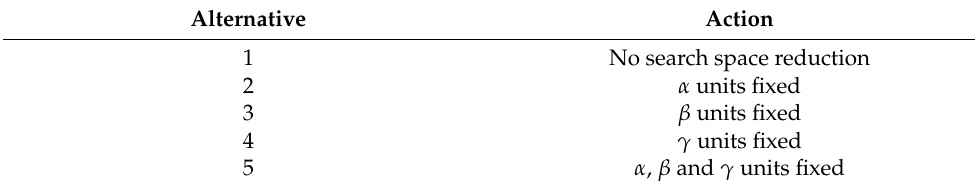
Table 5. Reduction alternatives based on Equation (12).